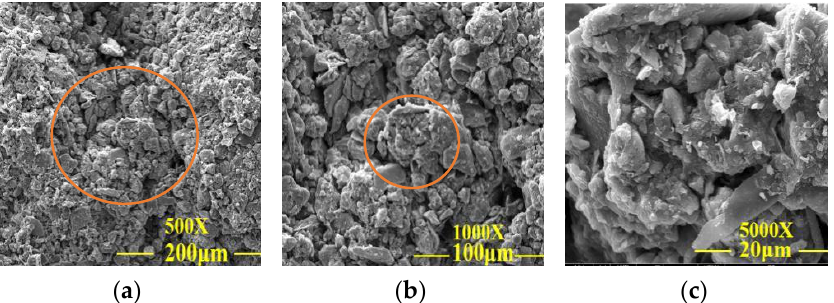
Figure 9. SEM images of the plain soil test group. ( a ) SEM analysis at a magnification of 500×; ( b ) SEM analysis at a magnification of 1000×; ( c ) SEM analysis at a magnification of 5000×.